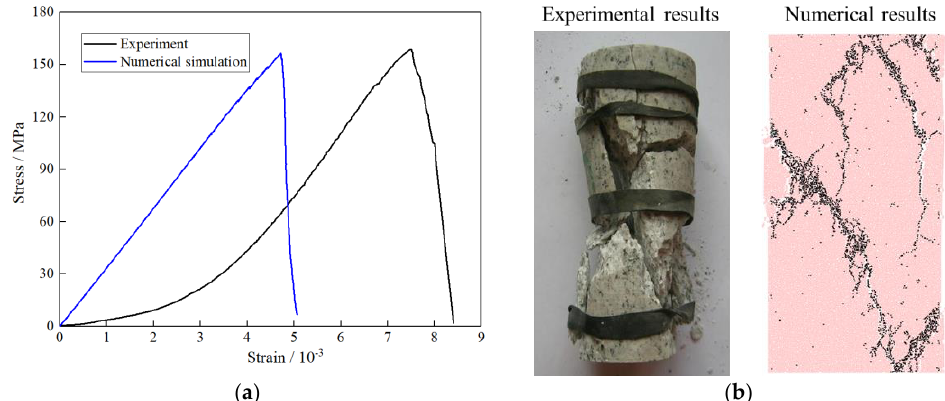
Figure 3. Experimental and numerical results of granite specimen under uniaxial compression: ( a ) stress-strain curve; ( b ) failure mode [24]. Table 1. Macro mechanical properties of materials.